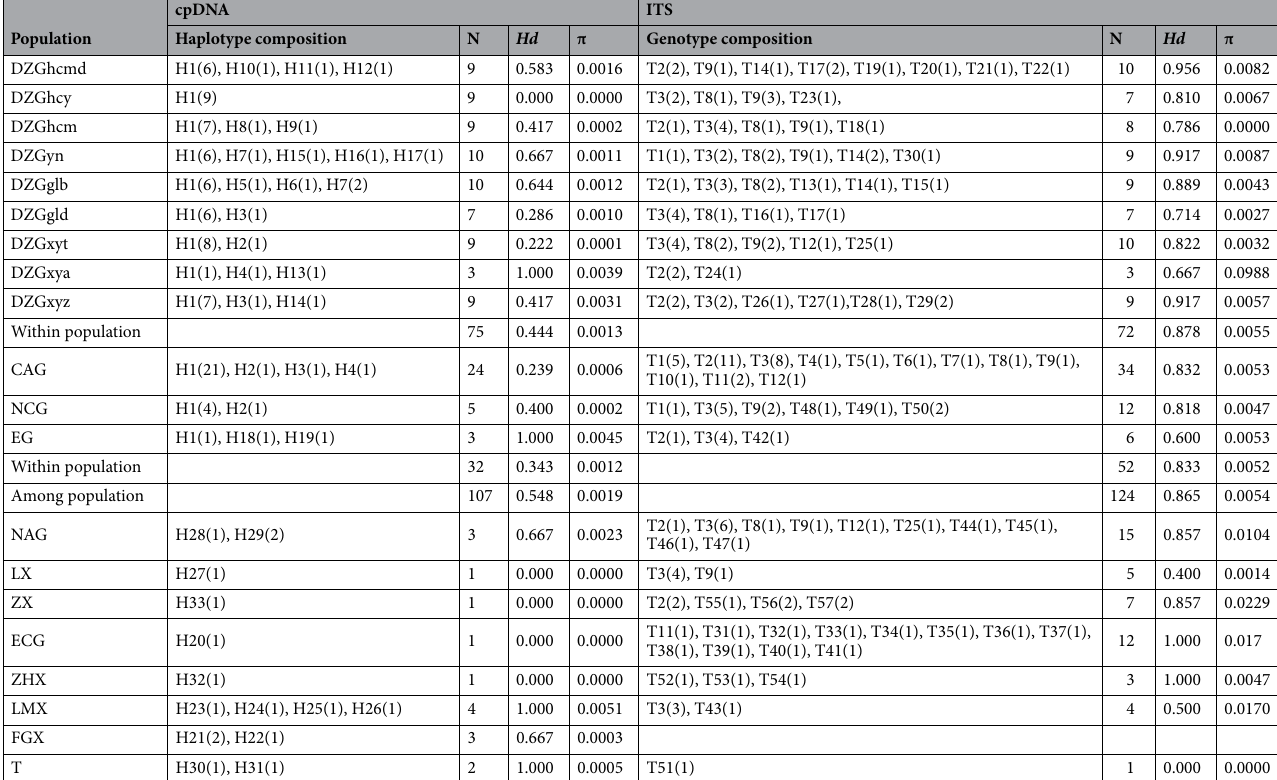
Table 2. Sample information and summary of haplotype/genotype distribution, genetic diversity for each population. N, sample size; Hd, haplotype/genotype diversity; π, nucleotide